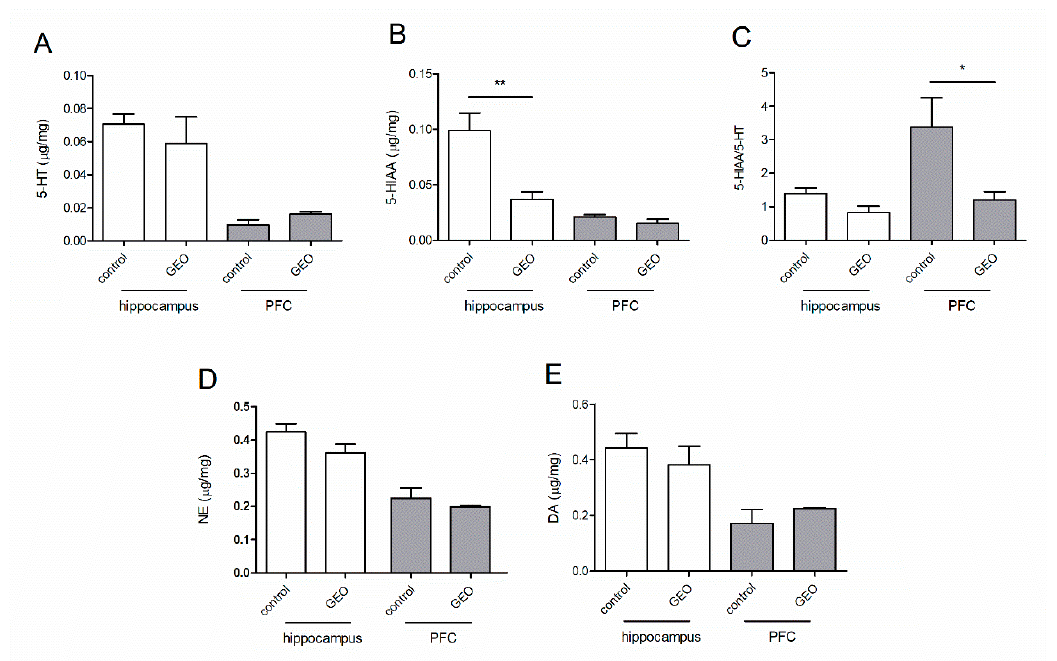
Figure 5. Changes in the contents of monoamine neurotransmitters in the prefrontal cortex and hippocampus of the mice after GEO exposure (0.2 mg / L). ( A – C ) Contents of 5-HT ( A ), 5-HIAA ( B ) and the ratio of 5-HIAA / 5-HT ( C ) in the hippocampus and PFC. ( D , E ) Contents of NE ( D ) and DA ( E ) in the hippocampus and PFC. Values represent the mean ± SE ( n = 5), * p < 0.05, ** p < 0.01; unpaired two-tailed Student’s t -test was used.